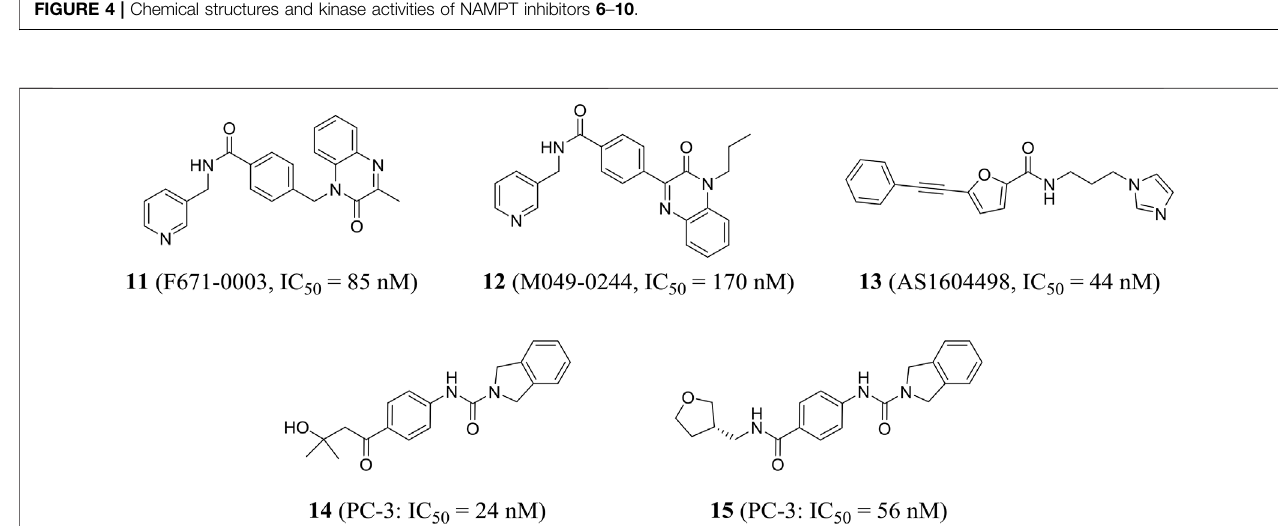
FIGURE 4 | Chemical structures and kinase activities of NAMPT inhibitors 6 – 10 .